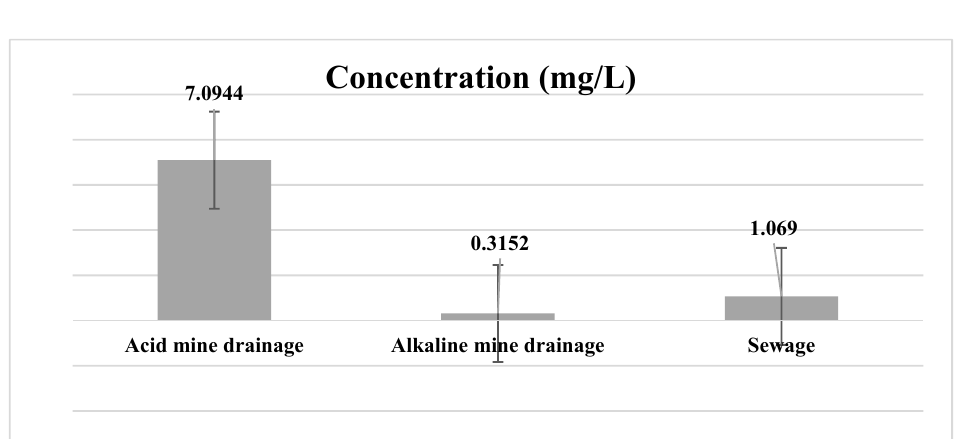
Figure 4. The concentration of total PAHs in the three different water samples studied.